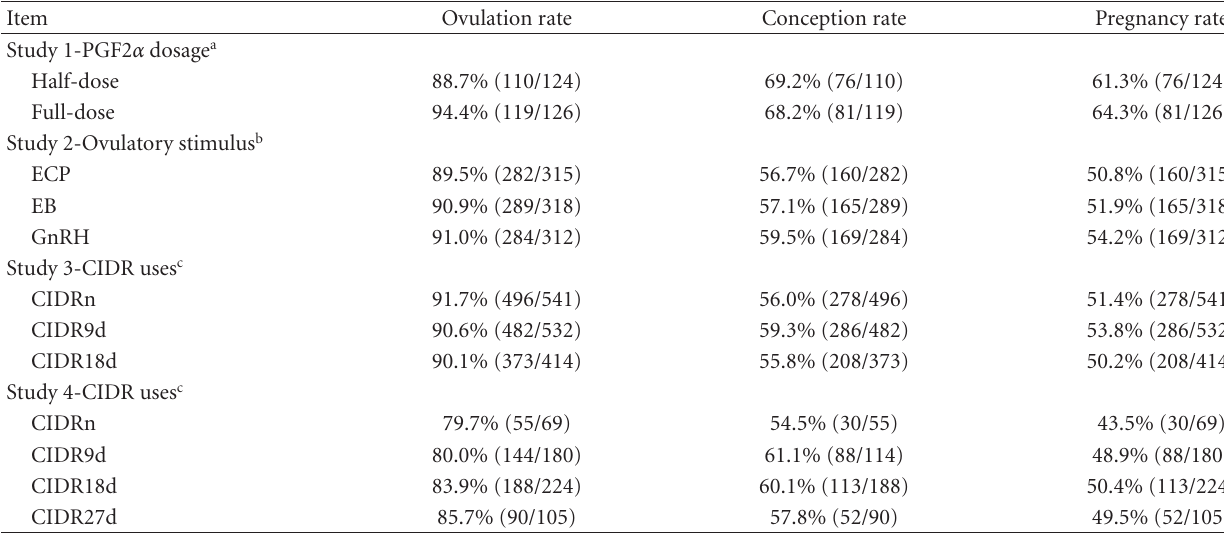
Table 2: Ovulation, conception, and pregnancy rates of suckled Bos indicus cows submitted to a synchronization of ovulation protocol using progesterone associated with estradiol having di ff erent dosages of PGF2 α (Study 1), ovulatory stimuli (Study 2), and uses of intravaginal progesterone insert (Study 3 and 4). Adapted from Meneghetti et al.